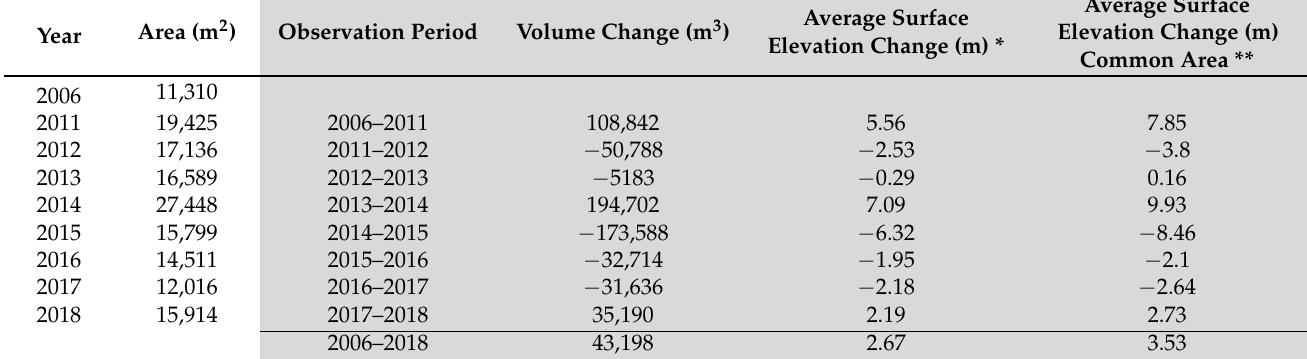
Table 4. Area, volume change and average surface elevation change of the Canin east GIP for the period 2006–2018. Areas of the ice patch at the end of the ablation season are showed in the left (White) part of the Table (First 2 columns from Left). Average surface elevation changes are reported both for the union of glacier areas at the beginning and at the end of the respective observation periods (*) and for the common area (**) on the right (Grey) side of the Table. The later data was used for the mass balance calculations, whereas the first for the volume change